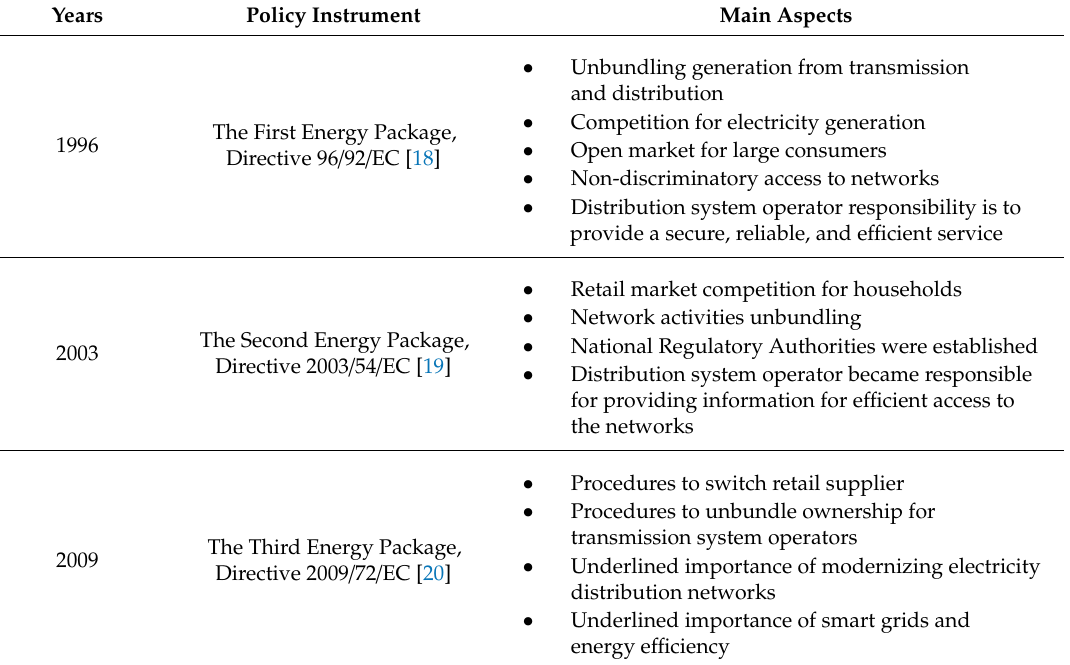
Table 1. Policy instruments for the EU electricity market liberalization. Source: data from [18–20].